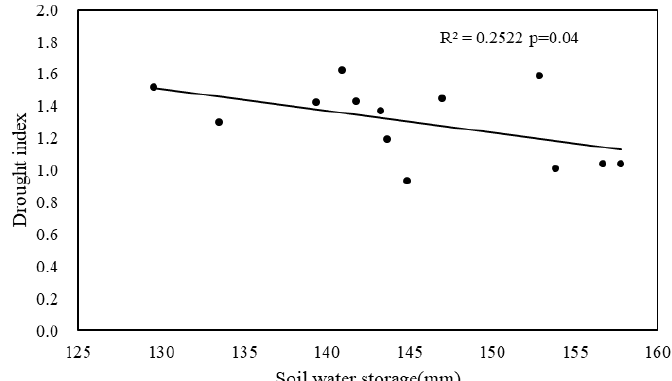
Figure 11. Relationship between soil water storage and drought.